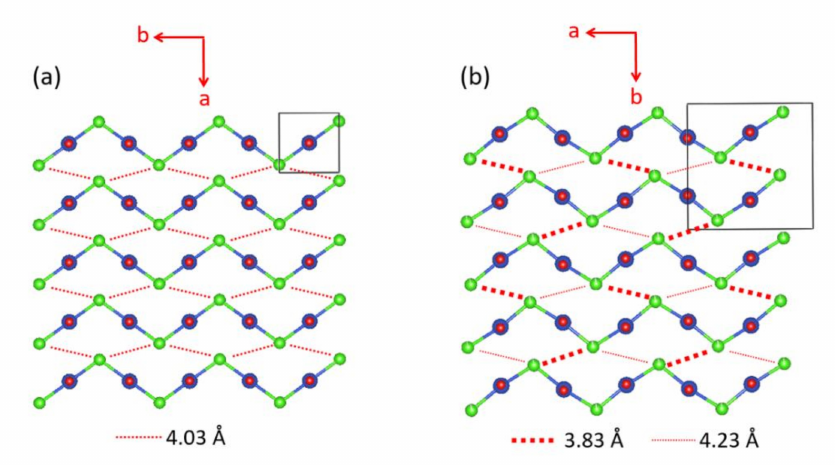
Figure 17. The structures of the CuClO 2 layer with cooperative Jahn–Teller distortion in ( a ) the tetragonal and ( b ) orthorhombic phases of (CuCl)LaNb 2 O 7 . The Cl–Cu–Cl unit is linear in the tetragonal structure, but is slightly bent in the orthorhombic structure. The latter has an important consequence on the spin